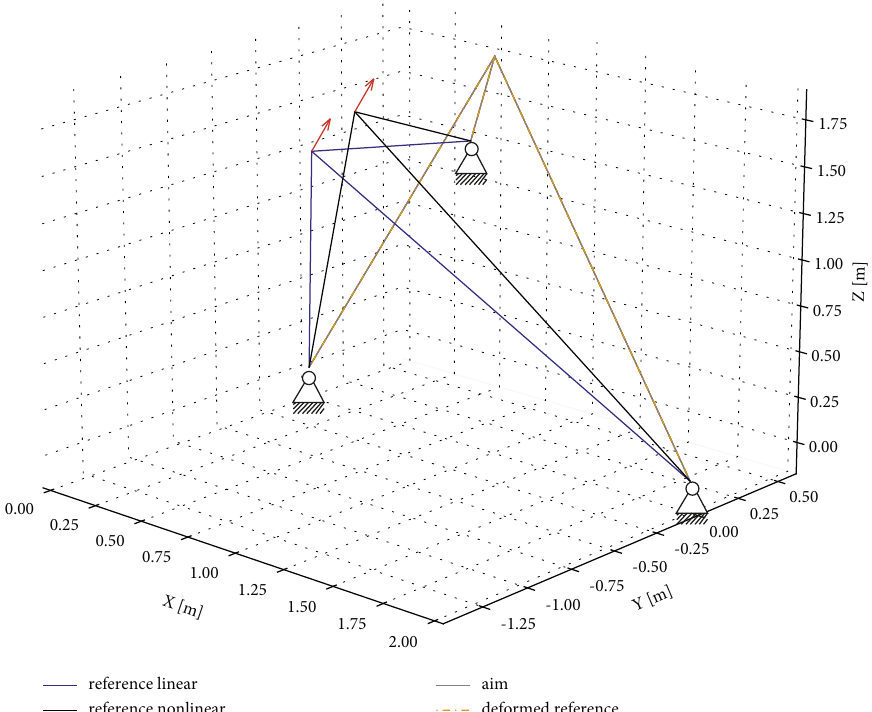
Figure 9: Unknown and known confguration of a 3-bar structure. Te red arrow demonstrates the force vector [ 1 e 3 , 0 , 2 e 3 ] N . Table 2: Solution of the initially unknown confguration and aim confguration of the 3-bar structure in Figure 9 with linear truss elements. X Y